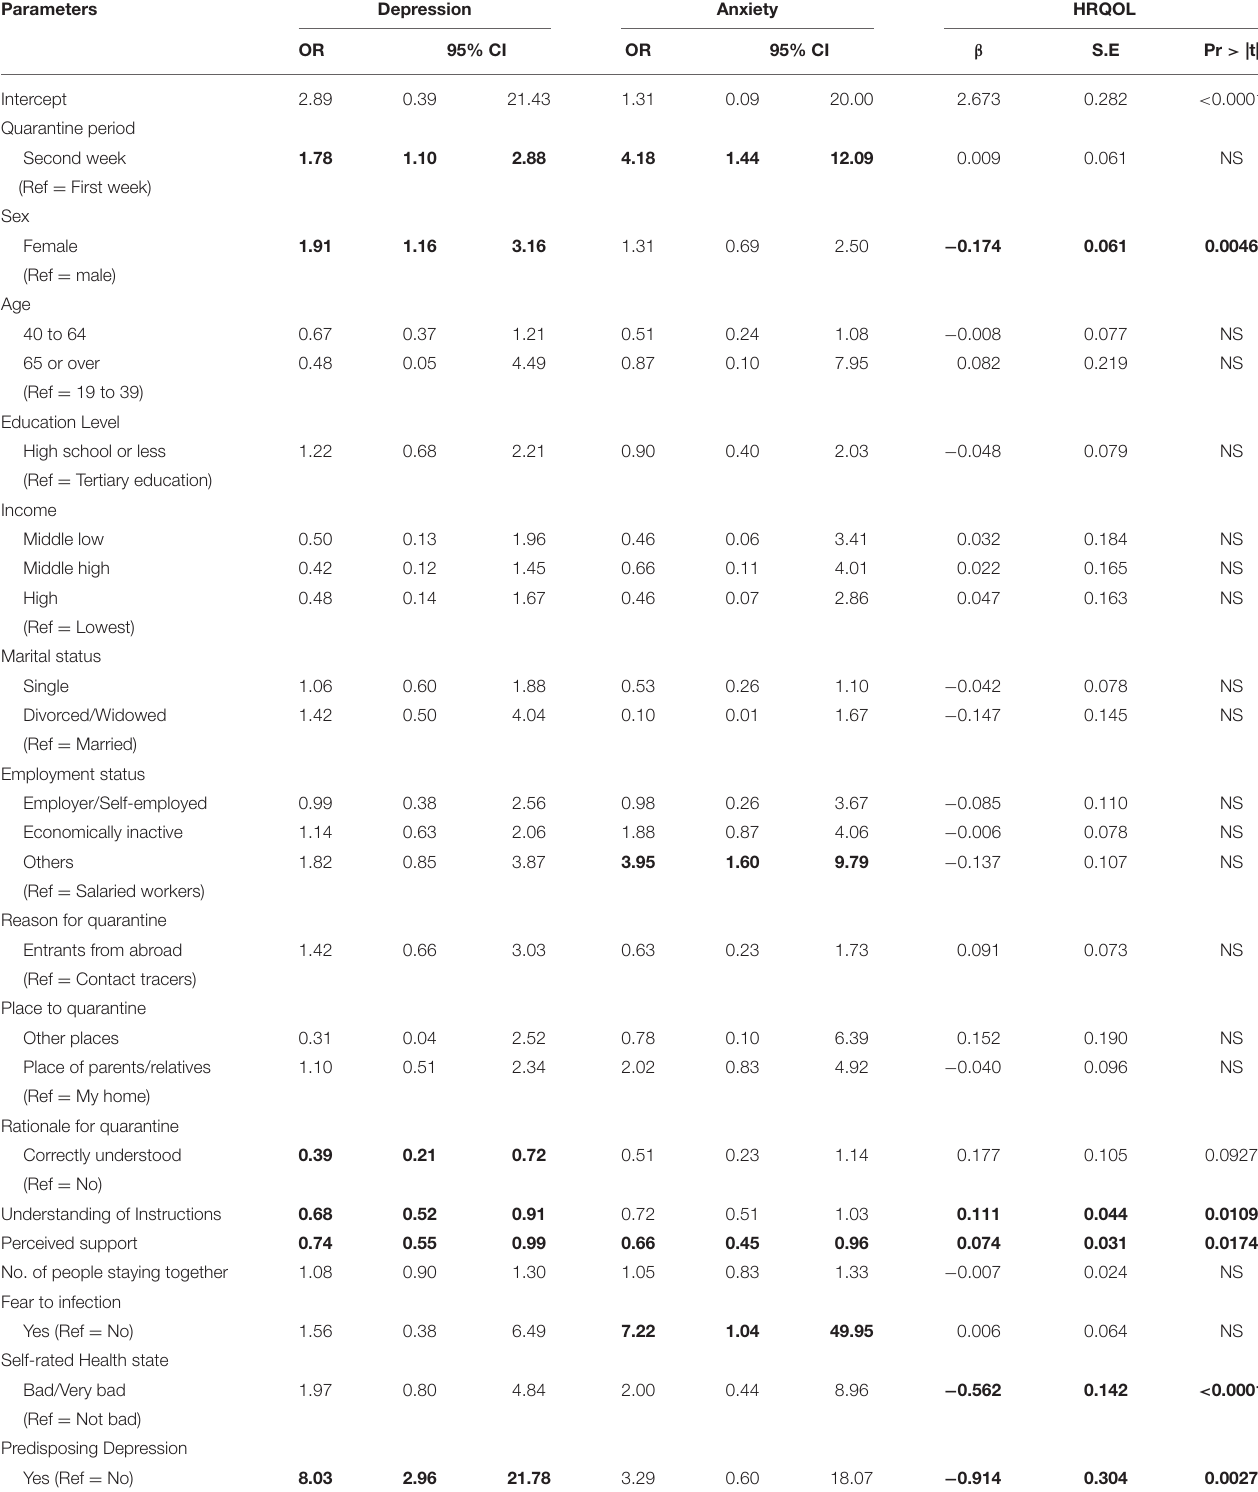
TABLE 3 | Results of the multivariable regression analyses investigating factors associated with depression, anxiety, and HRQoL.